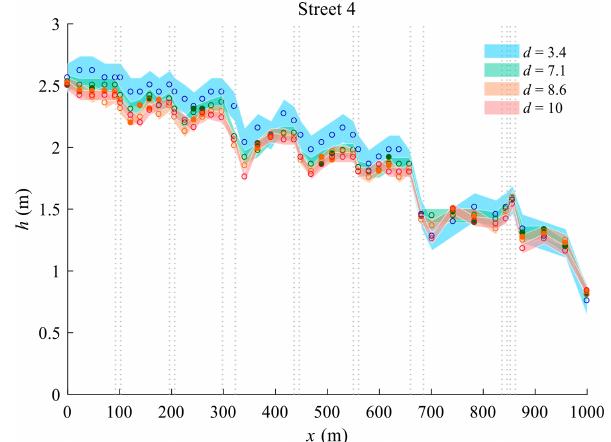
Figure 3. Upscaled water depth profiles in prototype in street 4 of Araud (2012) predictions, colour shade represents the upscaled measurement